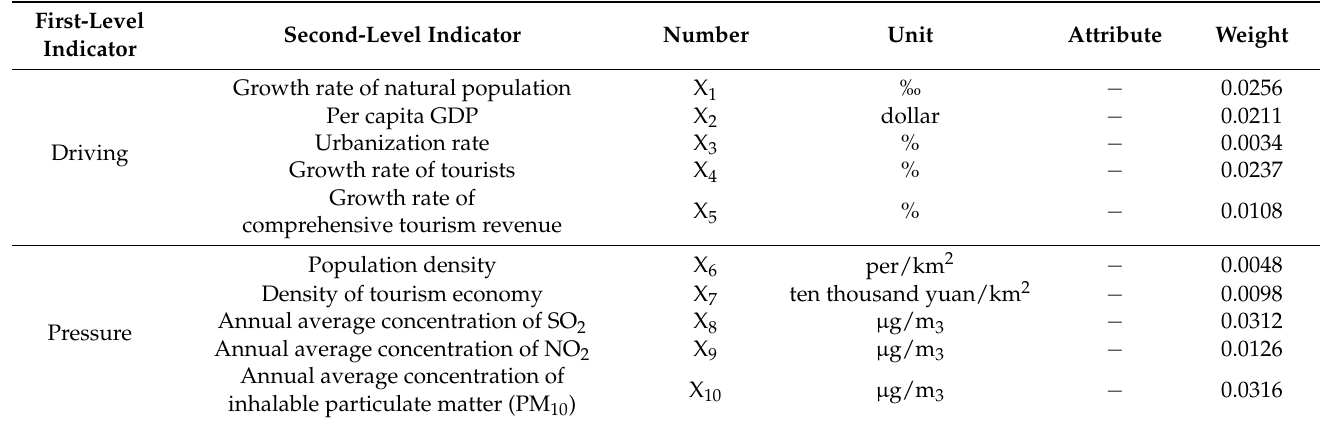
Table 1. Evaluation indicator system for tourism ecological